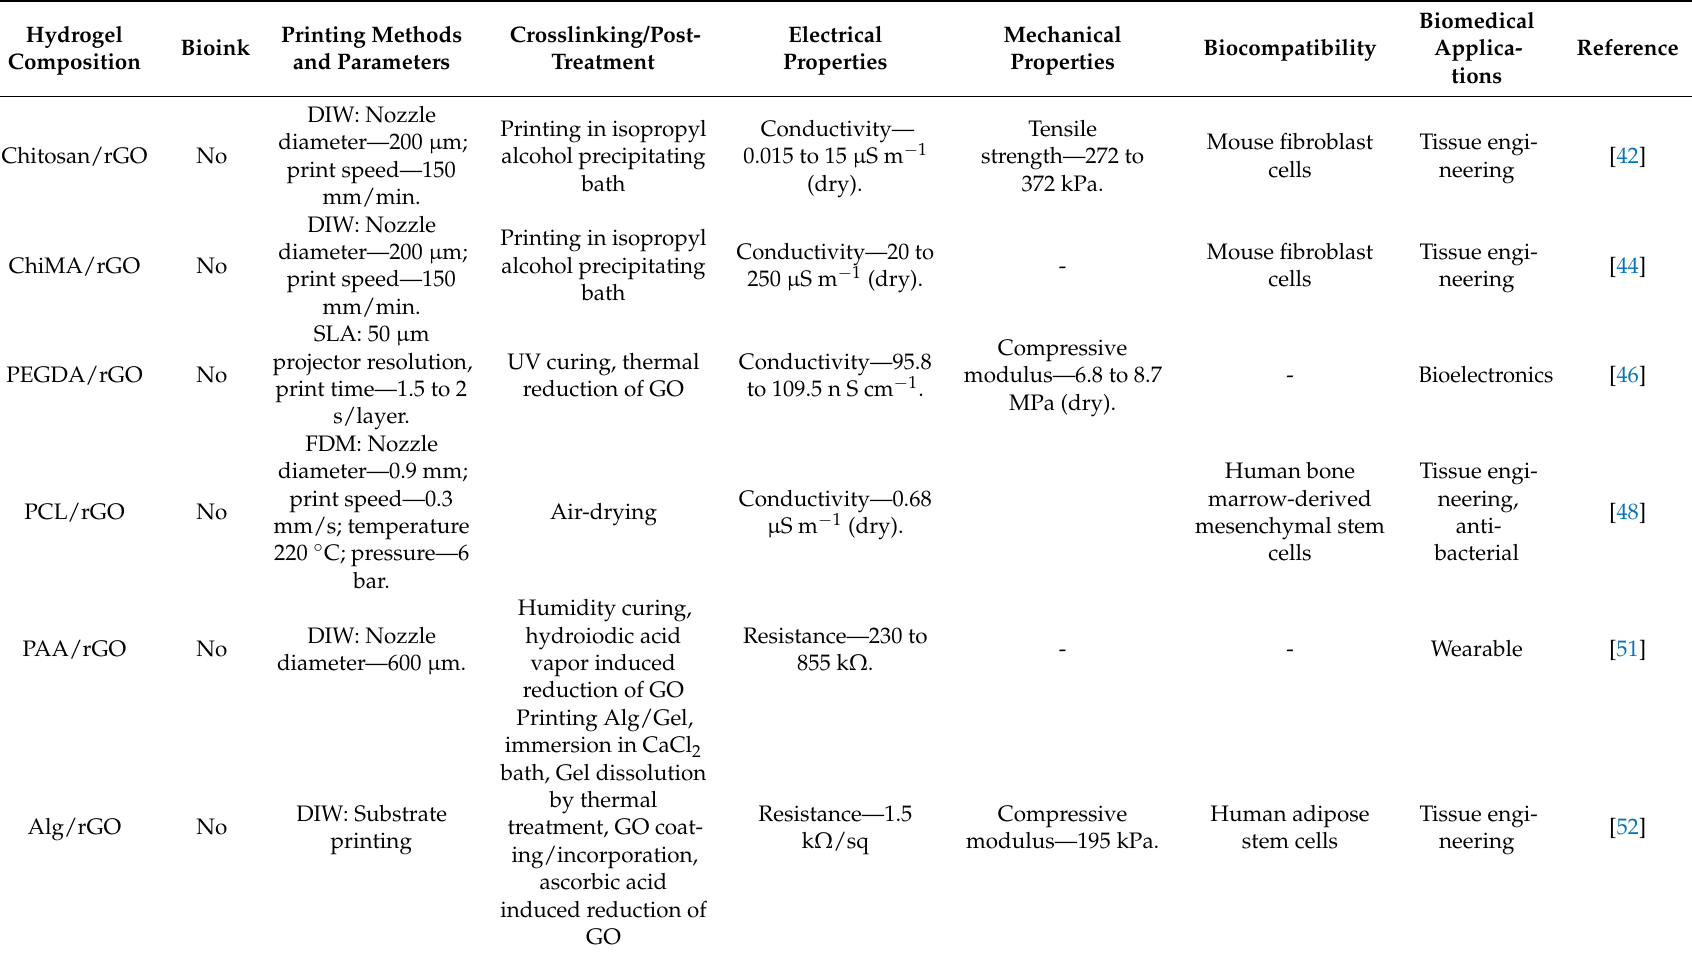
Table 2. Summary of 3D printed electrically conductive filler-based hydrogels and scaffolds for biomedical